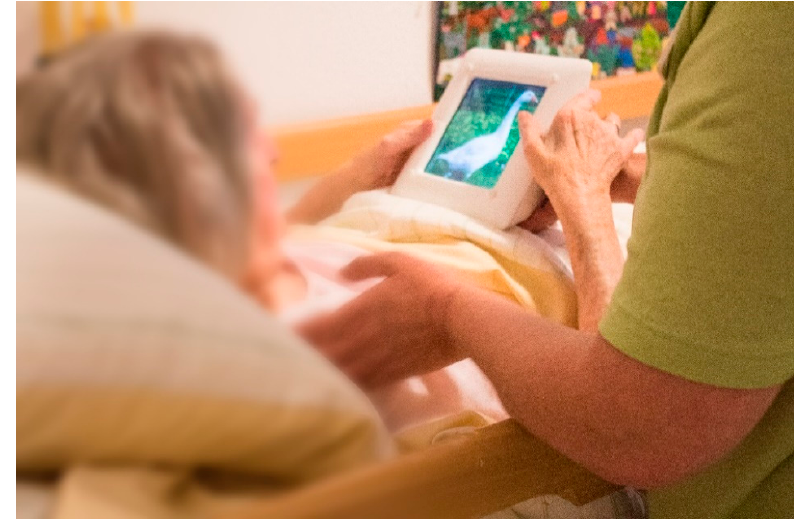
Figure 10. The “Pyramid” in a nursing home setting.